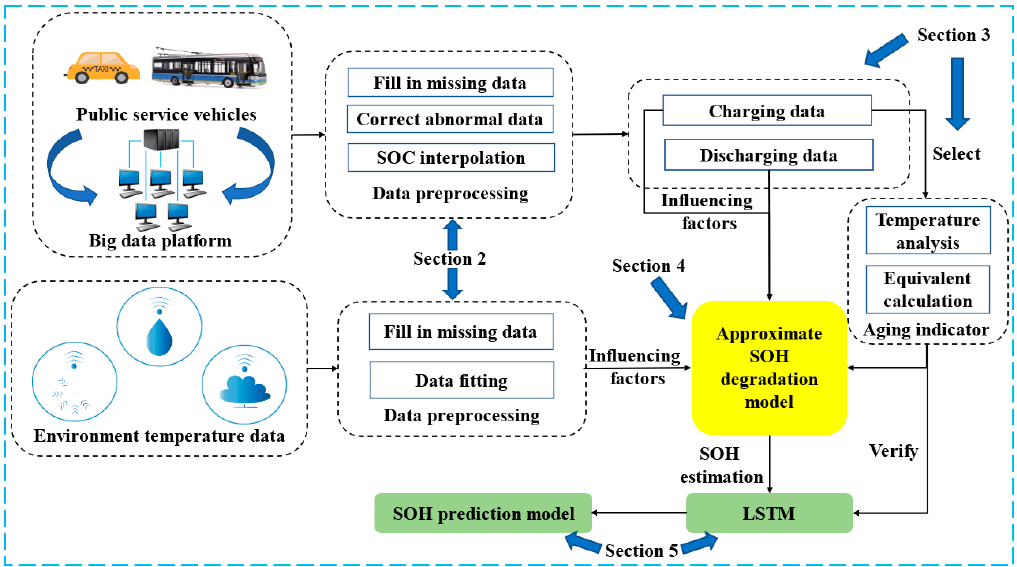
Figure 1. The flow chart of SOH estimation and prediction based on real-world data.